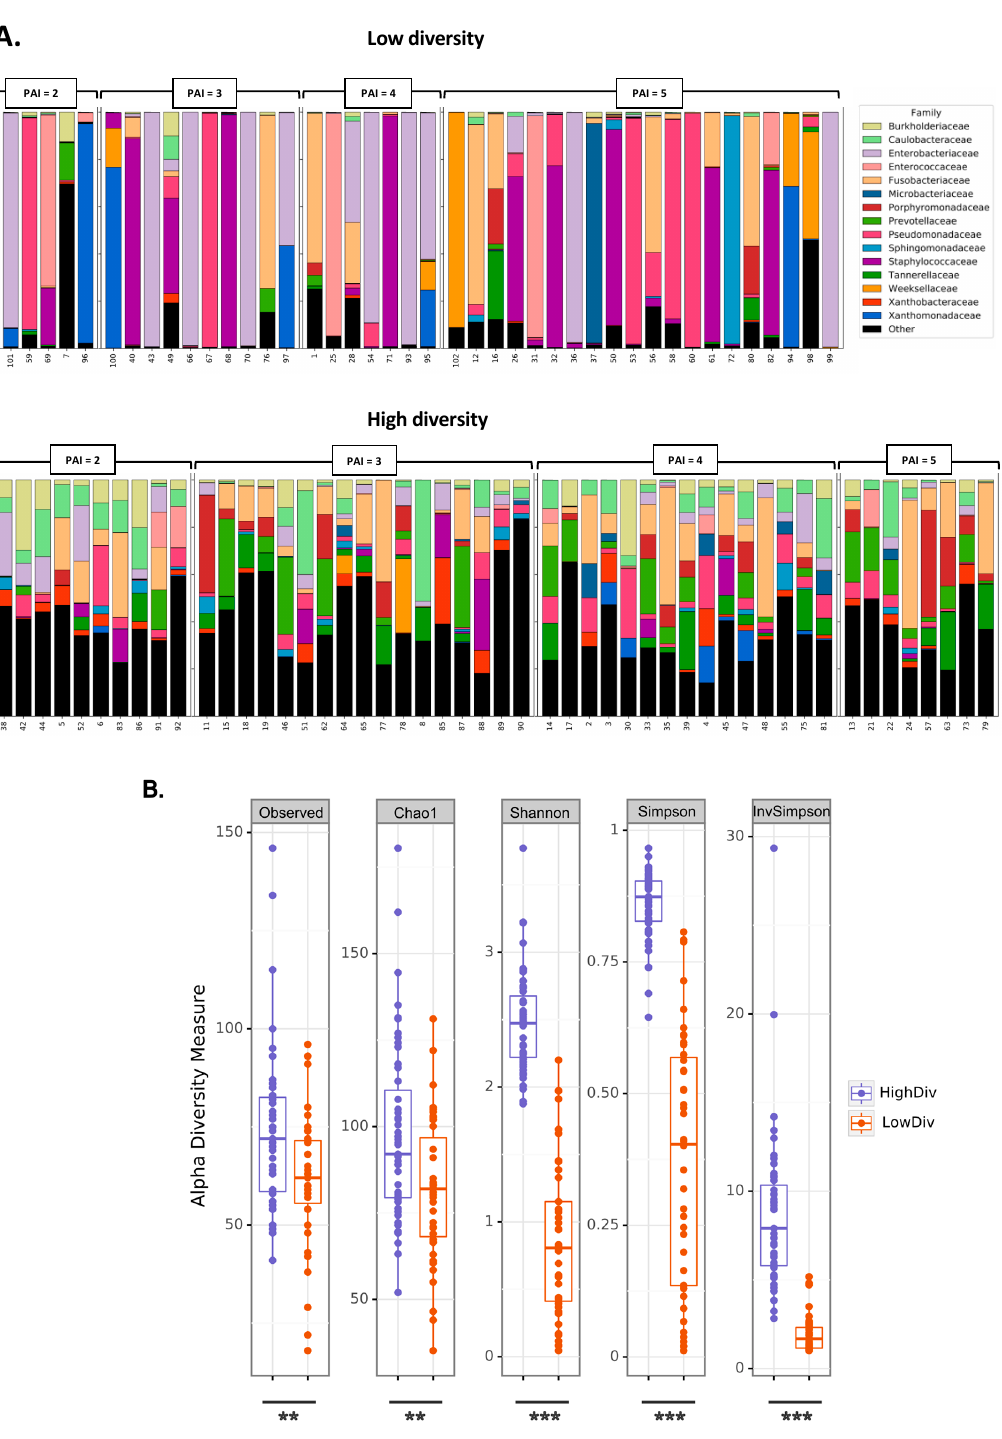
Figure 2. Microbiota profiles from granuloma split into low- (LowDiv, n = 43) and high-diversity (HighDiv, n = 51) profiles. ( A ) Granuloma microbiota composition at family level for low (upper panel) and high (lower panel) diversity. Only the top 15 most abundant families are displayed; the remaining families are aggregated in the “other” category. ( B ) Alpha diversity analyses at OTU level confirm low- and high-diversity microbiome profiles in granuloma. Boxplots show the distribution of bacterial richness (observed OTUs and diversity (Shannon and Simpson) values of granuloma microbiota between low- and high-diversity profiles. Statistically significant differences were determined using a Wilcoxon test (*** p value ≤ 0.001, ** p value ≤ 0.01).